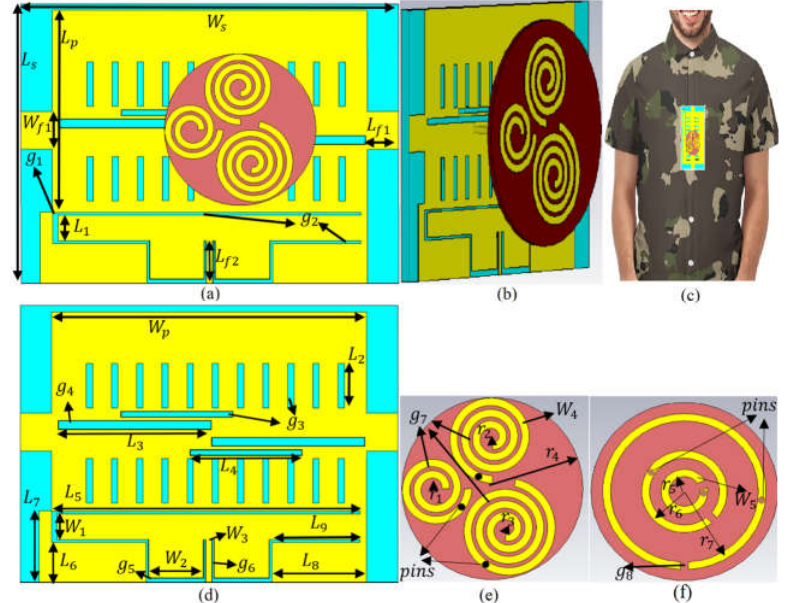
Figure 1. The proposed antenna’s simulated prototype (( a – c ) perspective view; ( d ) wearable LWA; ( e ) spiral button antenna; ( f ) ground view of the button